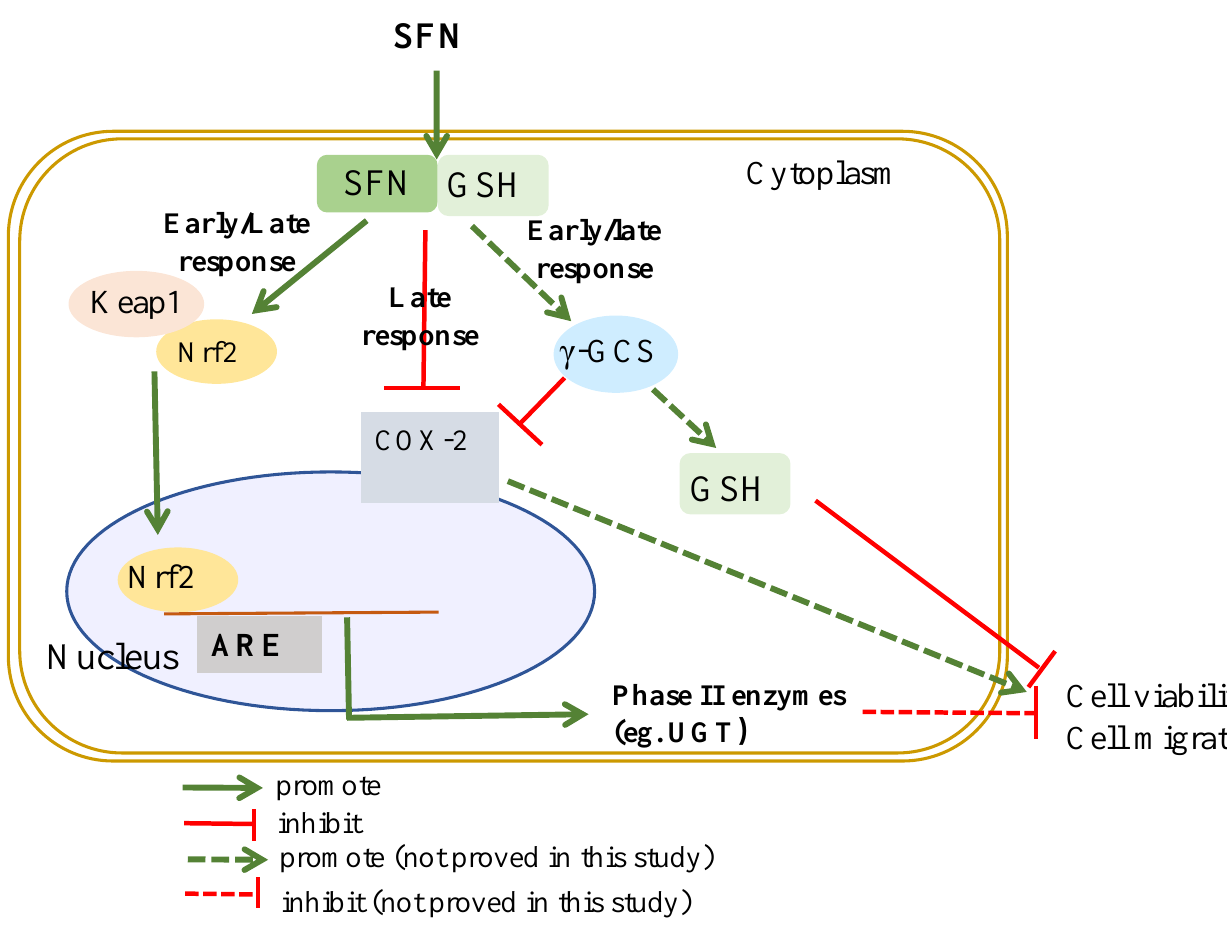
Figure 6. A proposed mechanism of the inhibitory effects of SFN on cell growth and migration.